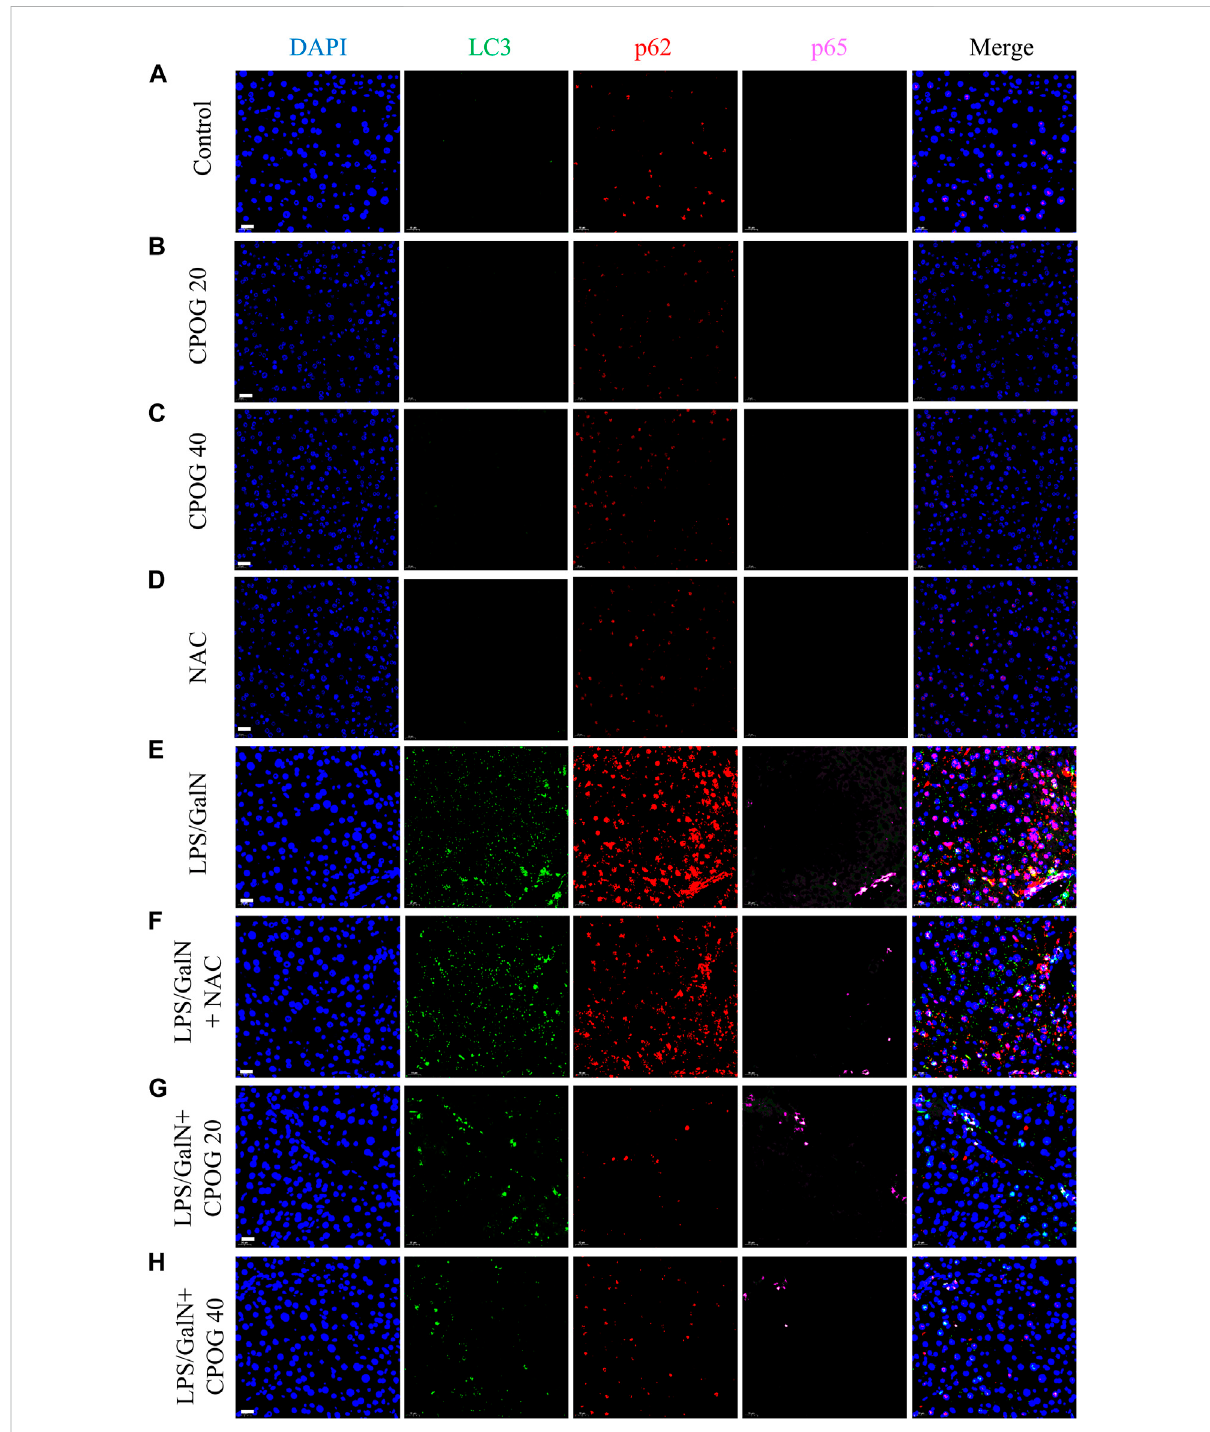
FIGURE 3 CPOG inhibited theexpression ofLC3B and p62 inLPS/D-GalN-inducedALF model. (A – H) Immuno fl uorescence imaging was performed with the indicated antibodies. The nucleus was stained with DAPI (blue color). Representative photographs were shown from vehicle mice (A) , mice treated with CPOG (20 mg/kg) (B) , mice treated with CPOG (40 mg/kg) (C) , mice treated with NAC (D) , mice treated with LPS/D-GalN (E) , mice treated with LPS/D-GalN and NAC (F) , mice treated with LPS/D-GalN and CPOG (20 mg/kg) (G) , mice treated with LPS/D-GalN and CPOG (40 mg/kg) (H) . Scale bar = 20